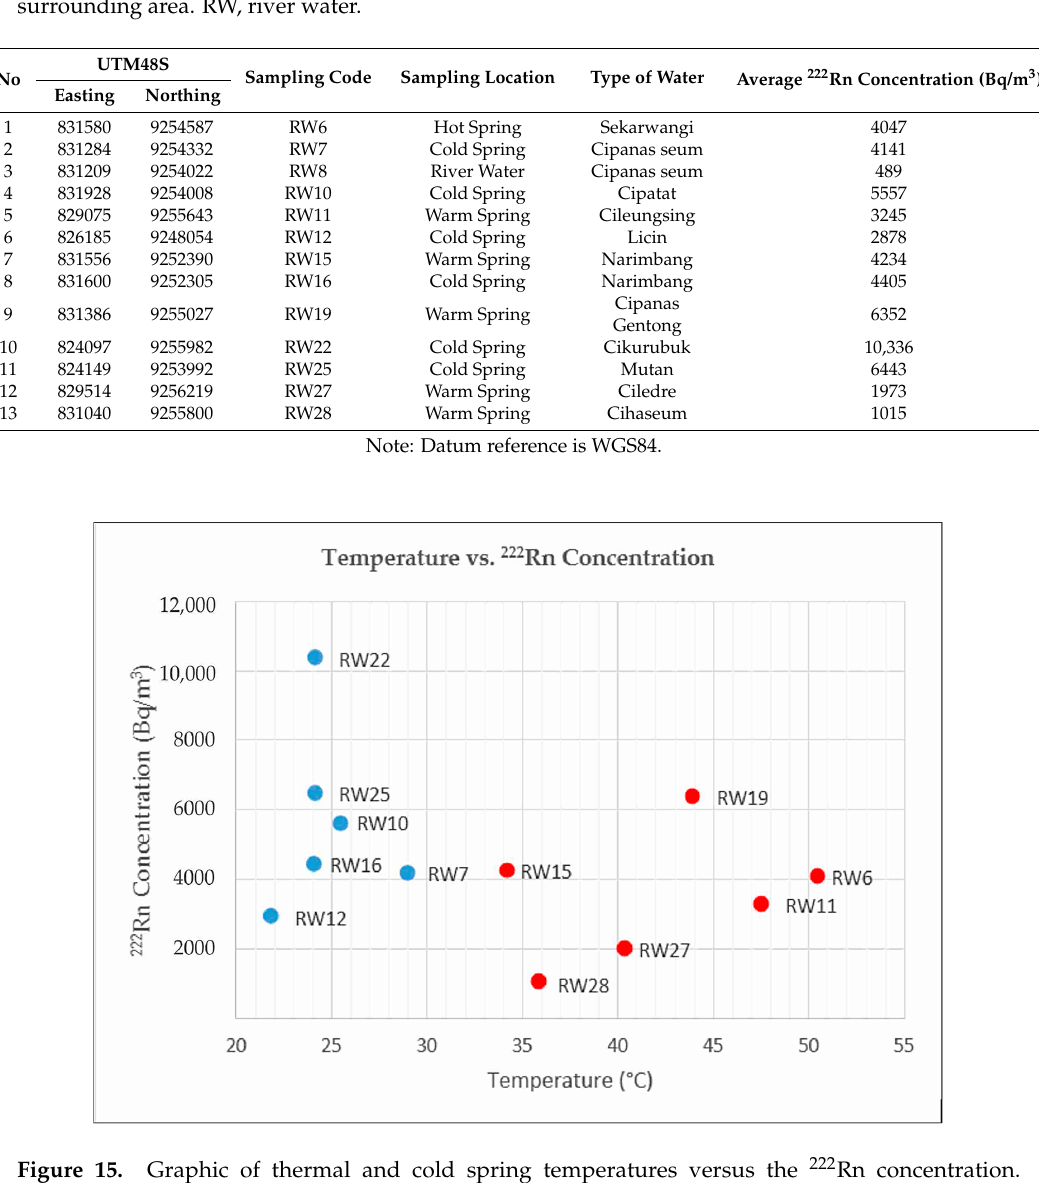
Table 11. Dissolved 222 Rn concentration based on in situ measurements of Tampomas and the surrounding area. RW, river water.